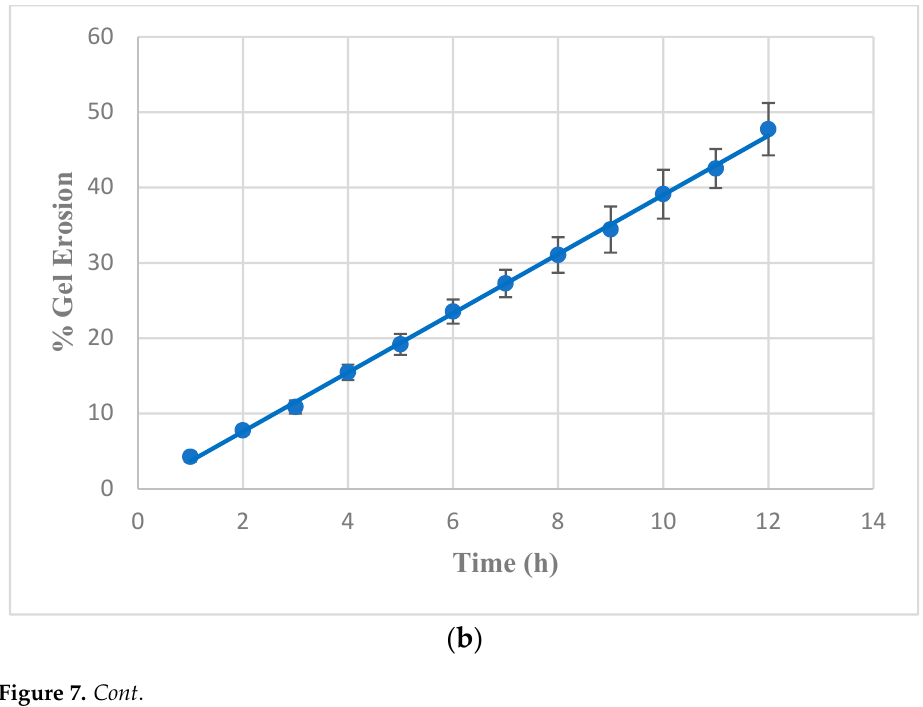
Figure 7. ( a ) Washability and ( b ) gel erosion pattern of P407 gel formulation in phosphate buffer. Figure 7. Cont .